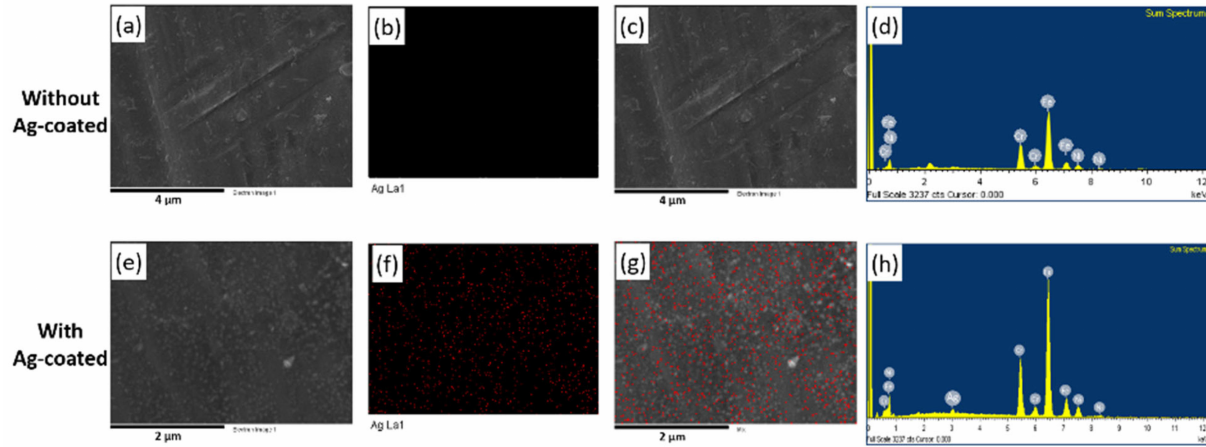
Figure A5. SEM images and corresponding Ag elemental mapping of surgical blades without ( a , b ) and with ( e , f ) Ag/PDA coating. SEM-EDX mapping of Ag ( c ) and ( g ). Figures ( d ) and ( h ) are energy-dispersive X-ray (EDS) spectra of the respective SEM